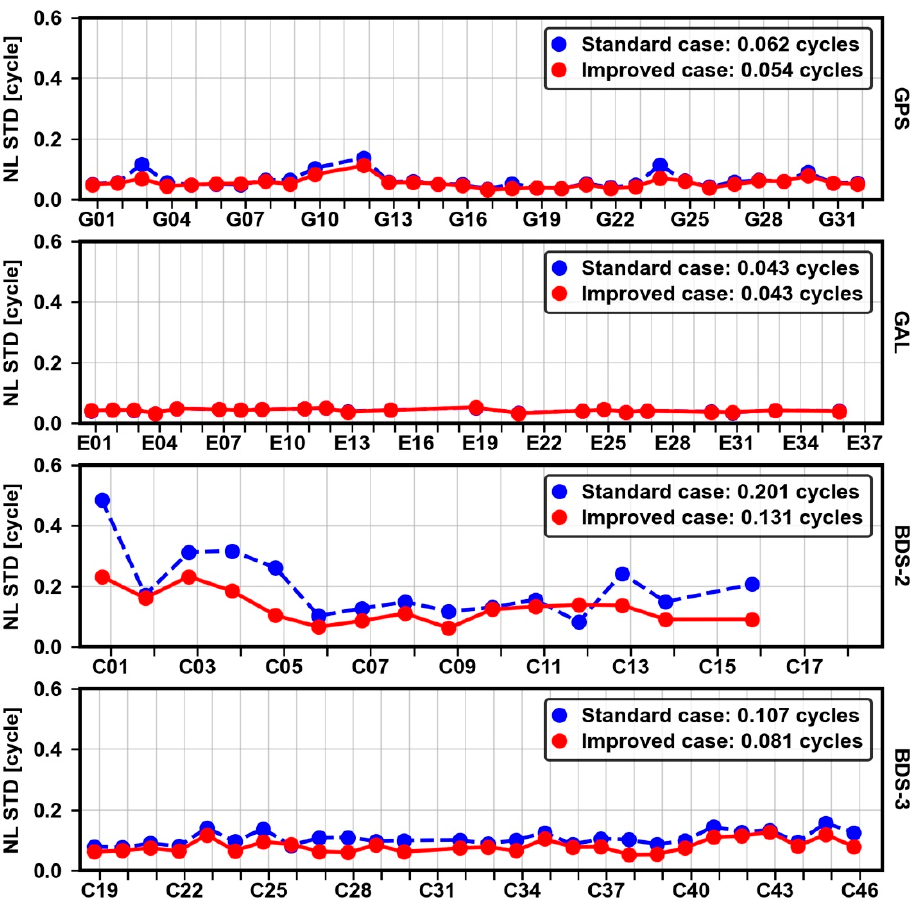
Figure 18. The STDs of NL phase bias series for multi ‐ GNSS for the standard case and improved case for the Case 4 network.